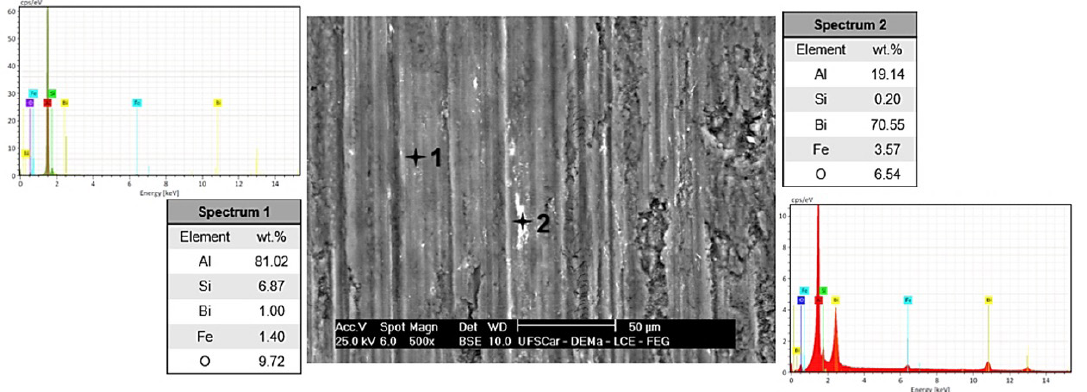
Figure 6. SEM image of the worn surface and EDS compositions of Bi-rich (Spectrum 2) and Al-rich (Spectrum 1) areas. It shows the action of the solid lubricant (brighter areas) which has been spread by the rotating